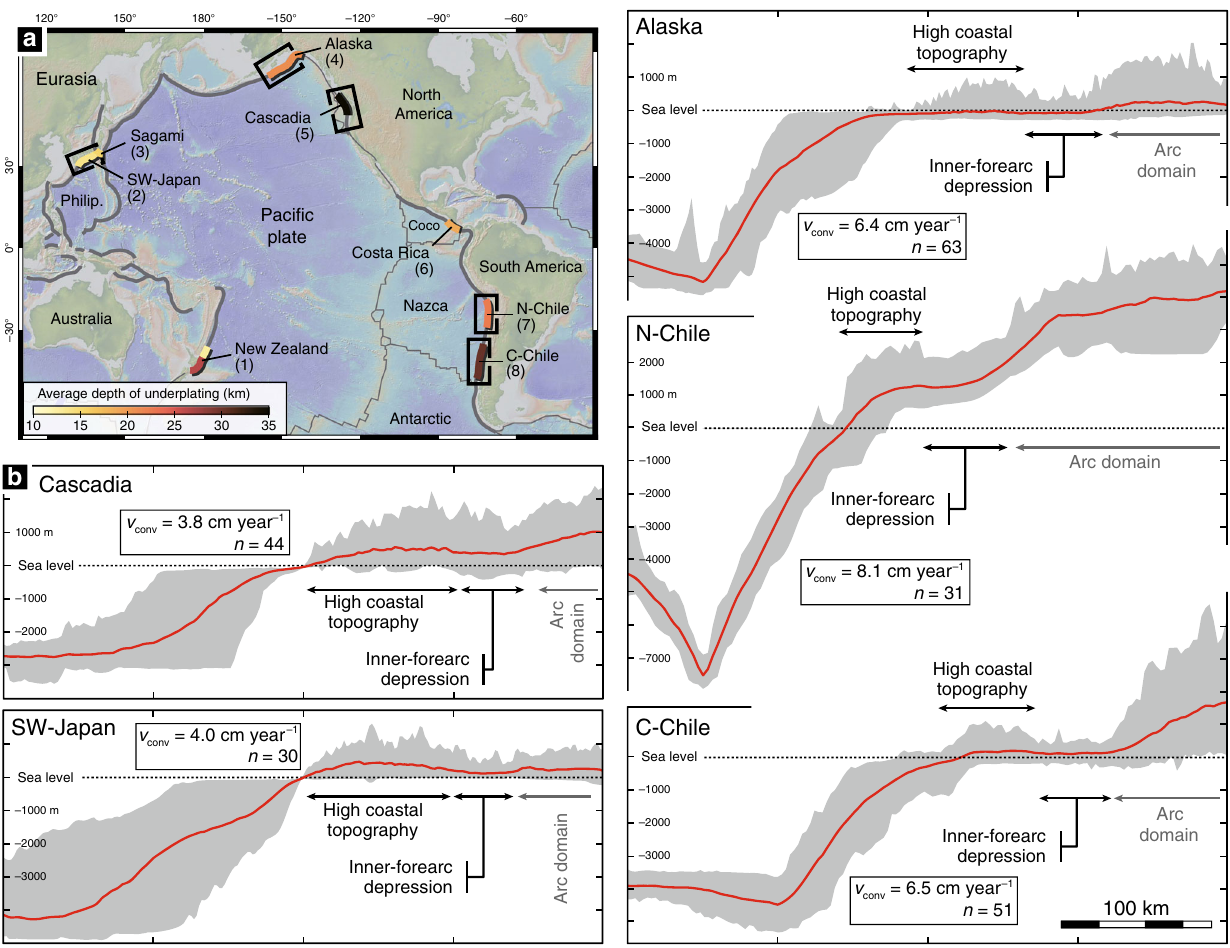
Fig. 1 Circum-Paci fi c forearc topography above deep-accretion sites. a The map shows ocean-continent subduction zones around the Circum-Paci fi c region with emphasis on segments where tectonic underplating is suspected, based on geophysical observations. (1) Hikurangi margin 64 – 66 , (2) Nankai margin 67 , (3) Sagami trough 23 , (4) Alaska margin 68,69 , (5) Cascadia margin 70 – 72 , (6) Costa Rica margin 73 , (7) North Chilean margin 74,75 and (8) Central Chilean margin 74,76 – 79 . Black frames locate regions where trench-perpendicular topographic pro fi les have been compiled. b Compilations of topographic pro fi les for different forearc regions. For each region, the forearc topography is characterized by a large, positive coastal topography and an inner-forearc depression. Thick red lines are mean topographic pro fi les while the grey area is de fi ned by the minimum and maximum elevation pro fi les. V conv denotes the plate convergence rate. n is the number of pro fi les considered for each region. Note that topography compilations are not provided for active margins characterized by particular geodynamic features, including subduction of a thick oceanic plateau (New Zealand) or a ridge (Costa Rica) and subduction edge (Sagami). Map and topographic pro fi les have been extracted from the Global Multi-Resolution Topography synthesis 80 with GeoMapApp [www.